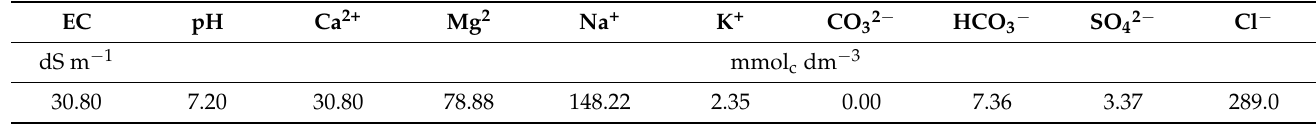
Table 2. Chemical characteristics of the water from the tube well used in the preparation of water of 2.4 and 4.8 dS m − 1